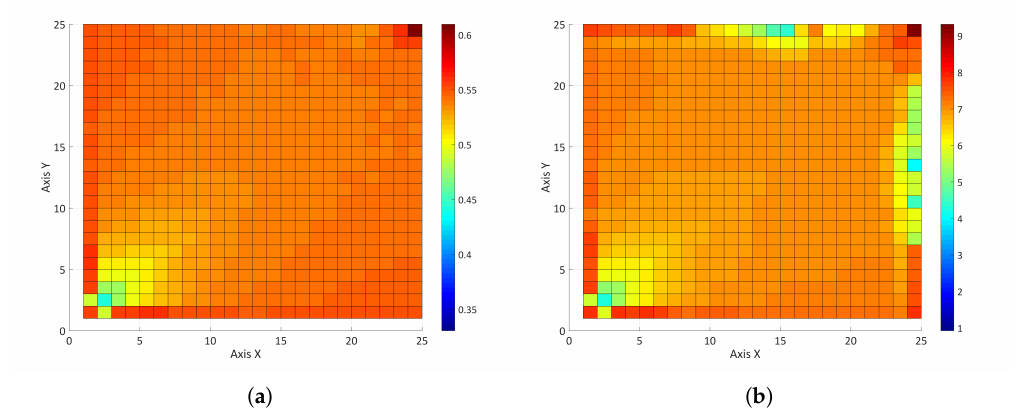
Figure 22. Partition Coefficient at the end of the EOR process under two different configurations of salt (initial/injected): 1.5/0.5% ( a ) and 1.5/1.5% ( b